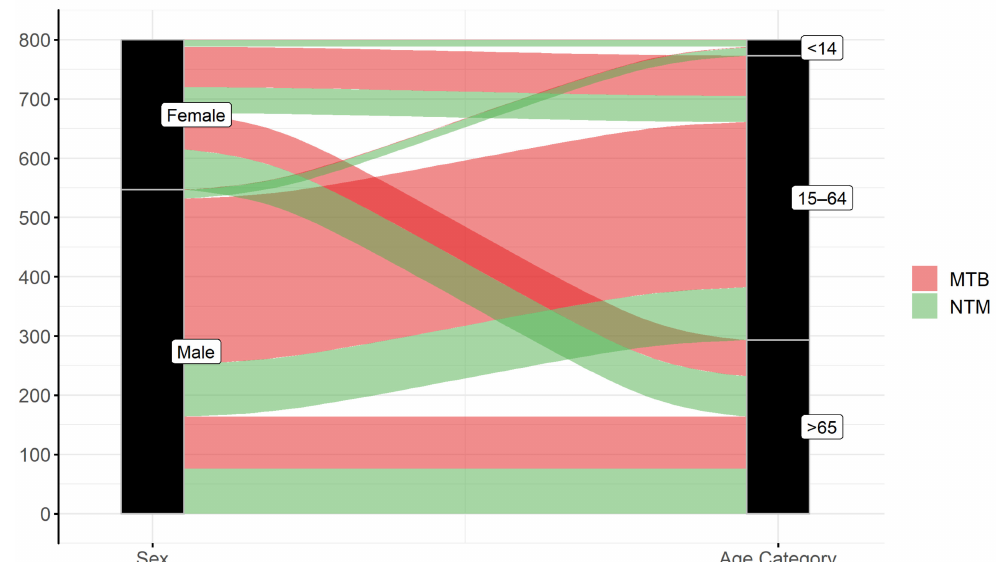
Figure 7. Sankey diagram: Comparison of the number of human tuberculosis (MTB, red color) and non-tuberculous mycobacteria (NTM, green color) patients with respect to gender (left) and age (right) in Moravian and Silesian territories of the Czech Republic (2012–2018). Males in the category 15–64 years su ff ered from MTB more often than NTM, but males 65 years and over had equal incidence of MTB and NTM. Total number of both MTB and NTM patients was lower in females in comparison to